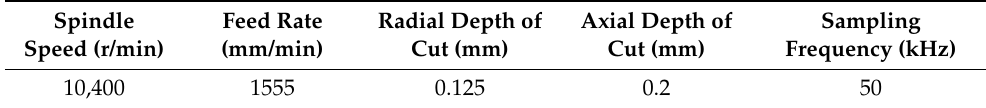
Table 1. Experimental processing parameters